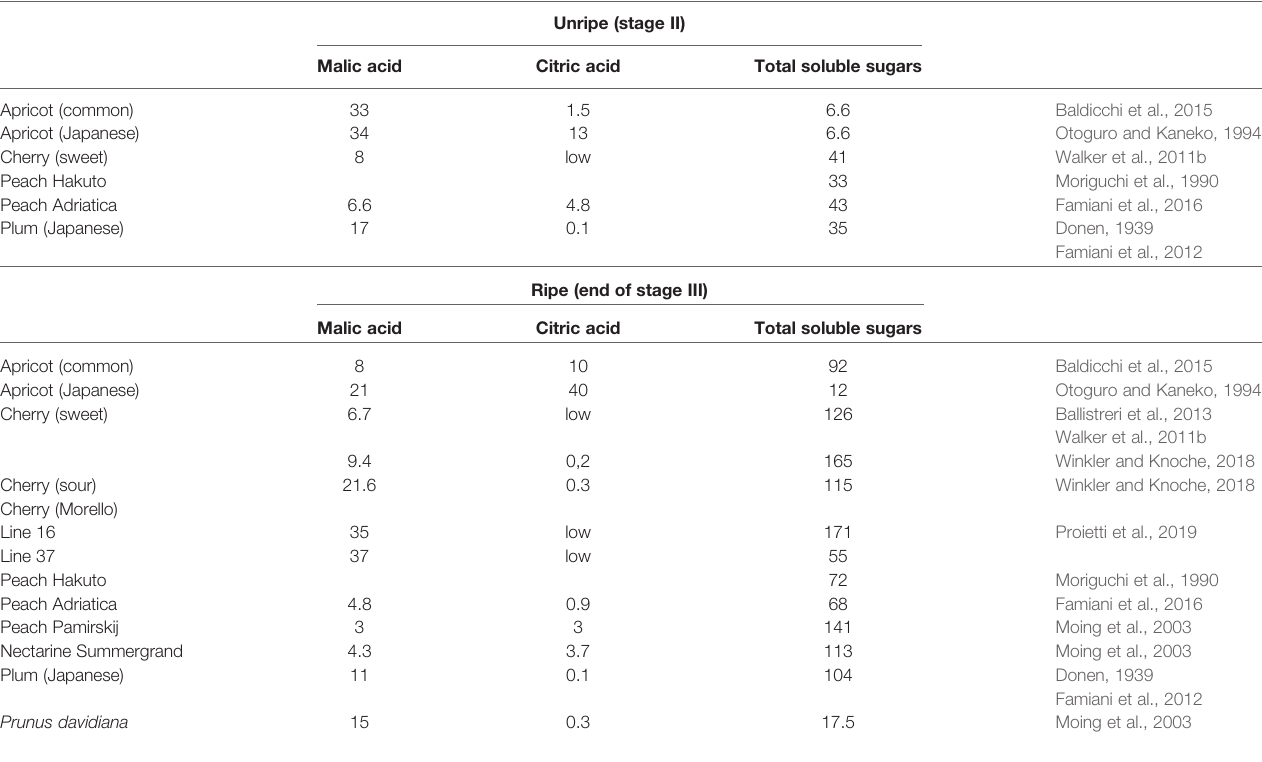
TABLE 1 | The concentration of organic acids (mg g -1 FW) in the fl esh of unripe and ripe stone